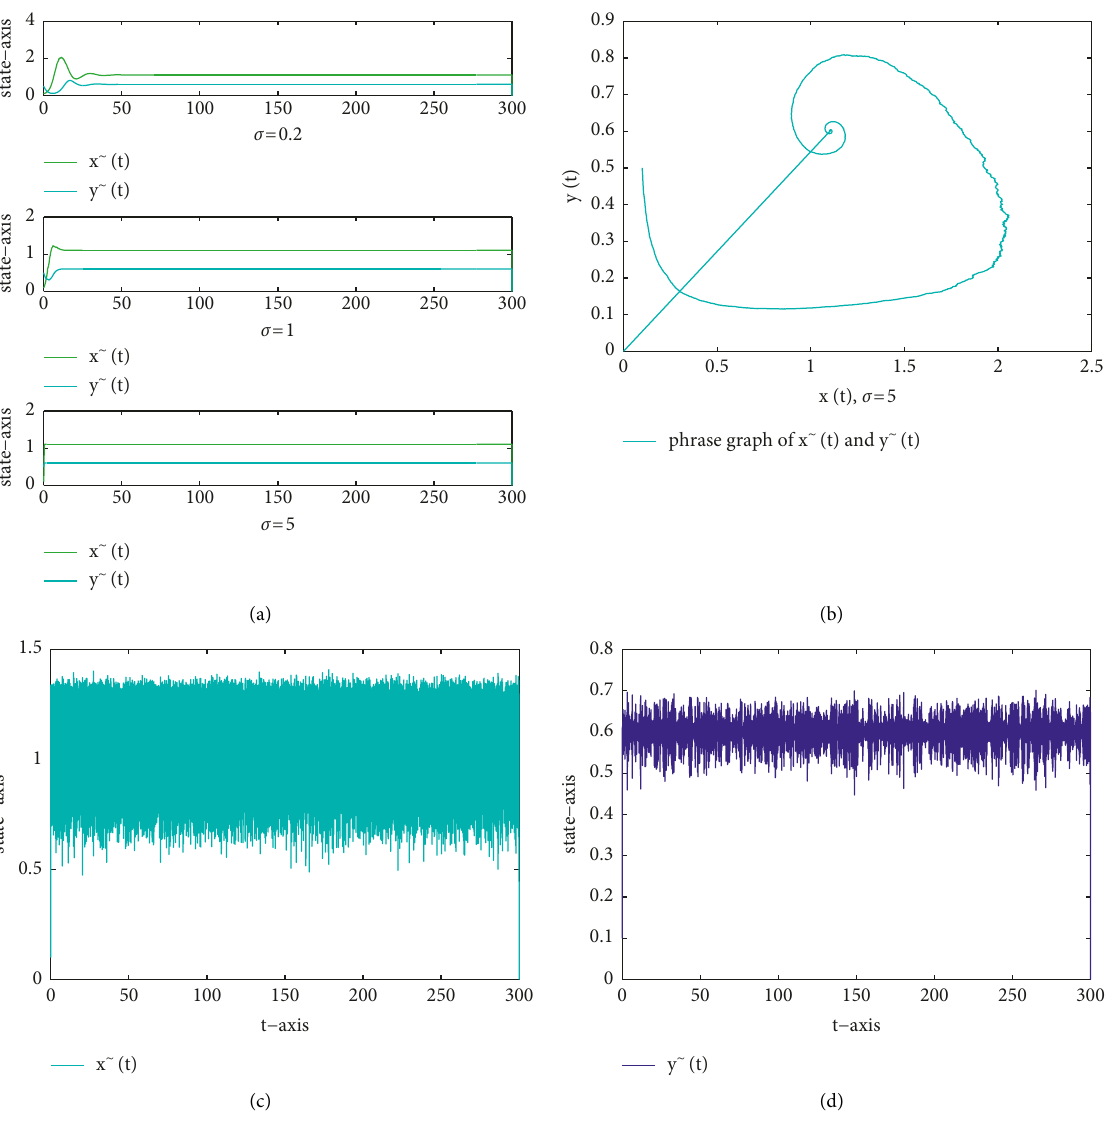
Figure 4: The impact of σ , i � 1 , 2 on the equilibrium state of (2) and (21) with different σ i y ∼ ( t ) , i � 1 , 2 , 3 represent the intensities of prey and predator species of (21), respectively. (a) The time series graph of prey and predator of i (21) with different stochastic parameters. (b) The phase graph of prey and predator of (21) with σ � 20 , σ � 26. (d) The time series graph of predator of (21) with σ of (21) with σ 1 2